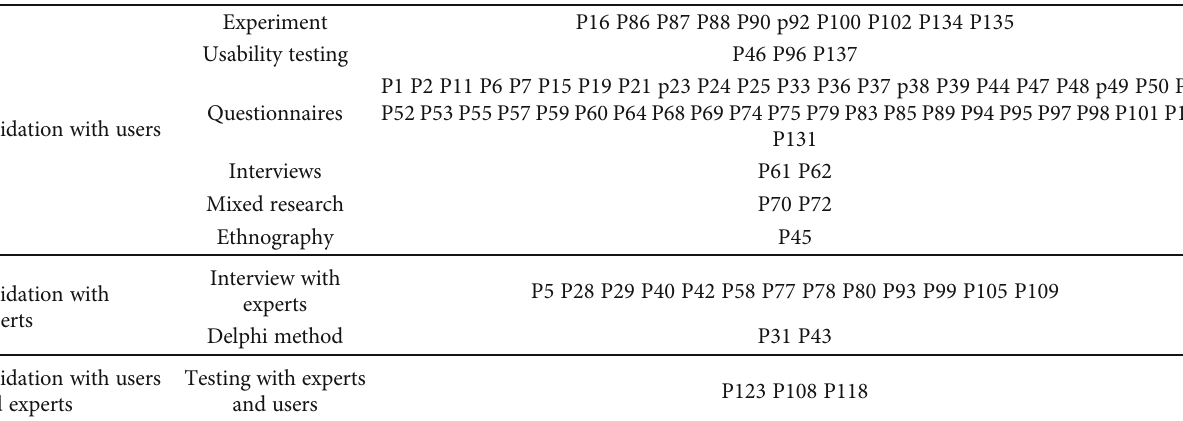
Figure 6: Validation Table 11: Studies by validation methods.